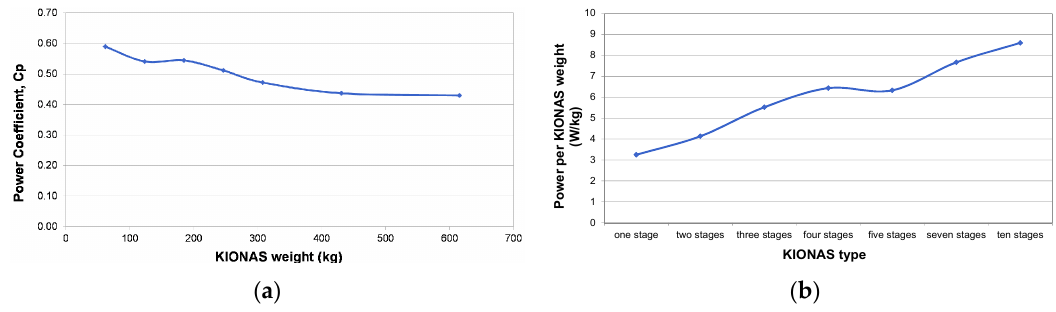
Figure 11. ( a ) Power coefficient vs KIONAS weight; ( b ) Power per weight for various KIONAS types.